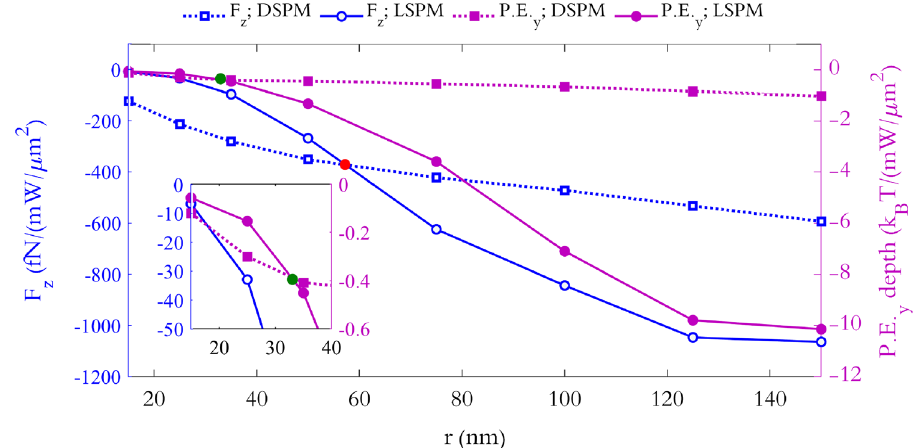
Figure 9. The left green axis presents the maximum exerted F z , at x = 0 nm and y = 300 nm for LSPM, and at x = 0, y = 145 nm for DSPM, versus different radii of the particle. The particle is assumed at a vertical distance of 10 nm from the nano-discs surface. The purple right axis represents the depth of the potential well along the y direction, exerted to particles with r = 15–150 nm. The inset exhibits the magnified view of the LSPM (solid purple) and DSPM (dotted purple) P.E. y depth variations around their intersection, marked by blue dot. The red dot highlights the intersection of the F Z curves relating to LSPM and DSPM trapping